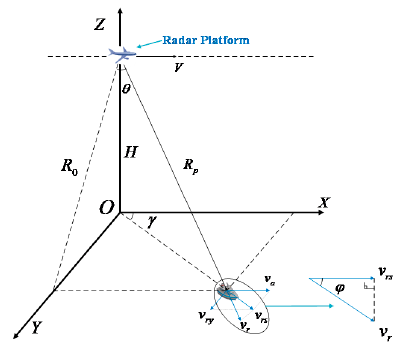
Figure 1. Geometry of squinted SAR with a moving ship.